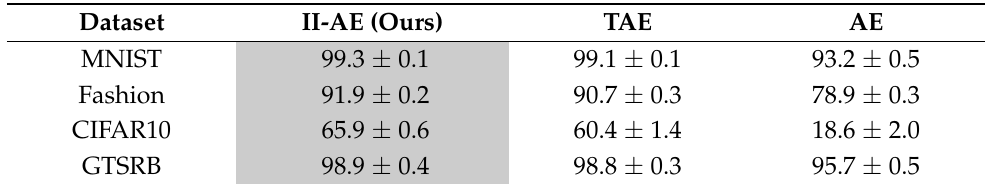
Table 1. Mean and standard deviation test accuracy over 10 runs by a linear SVM classifier trained in the latent space of different autoencoders after the latter finished training. We either used the triplet loss (TAE), the second variation of the PIRL (II-AE) or just the vanilla reconstruction loss (AE).